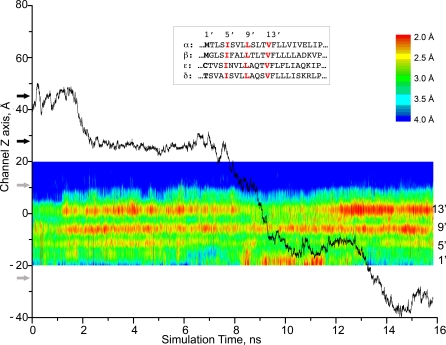
Position of the Cation Along the Channel Axis from the Simulation in Figure 1 Superimposed upon a Color-Encoded Plot of the Effective Pore Radius (See Calibration Scale), Measured Using the Program HOLE [30]The Z-axis position of the lipid membrane spans from −20 to 20 Å. Gray arrows indicate previously described extracellular and intracellular rings of charged residues [1], while the black arrows indicate two more rings of charge coinciding with prolonged dwell times of the cation. Residues of TMD2 that line the channel are indicated by consensus position numbers from intra-cellular to extra-cellular, 1′, 5′, 9′, and 13′.